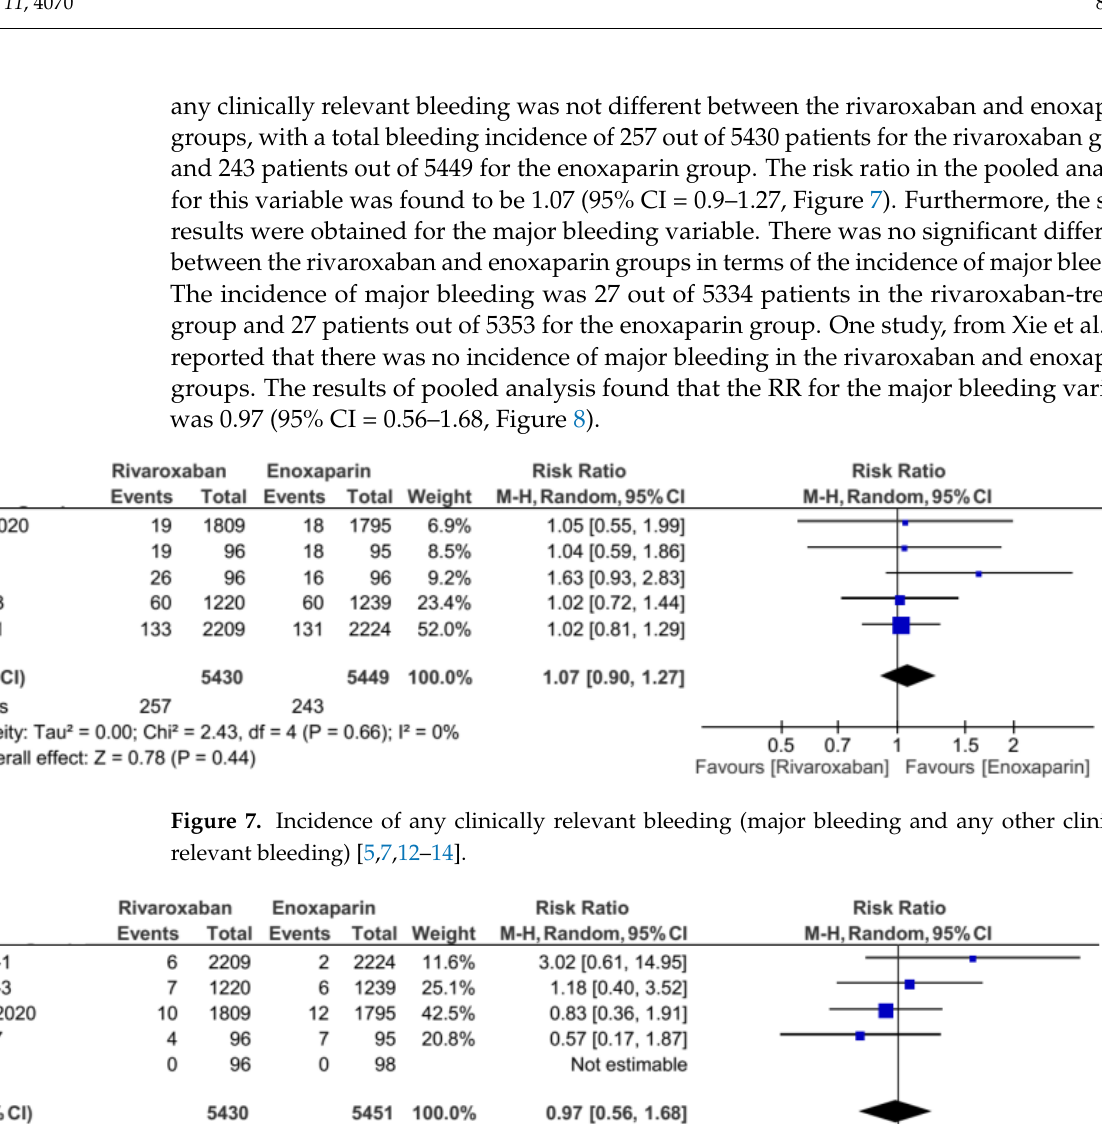
Figure 6. Major VTE [5,7,12 – 14].